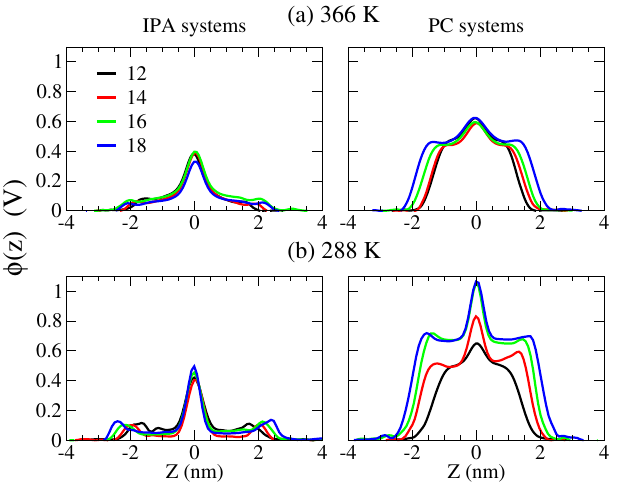
Figure 9. Electrostatic potential profiles along the bilayer normal at ( a ) 366 and ( b ) 288 K for C n TMA-C n S IPA and DC n PC bilayers. The color codes for the alkyl chain lengths are black, red, green, and blue for n = 12, 14, 16, and 18,